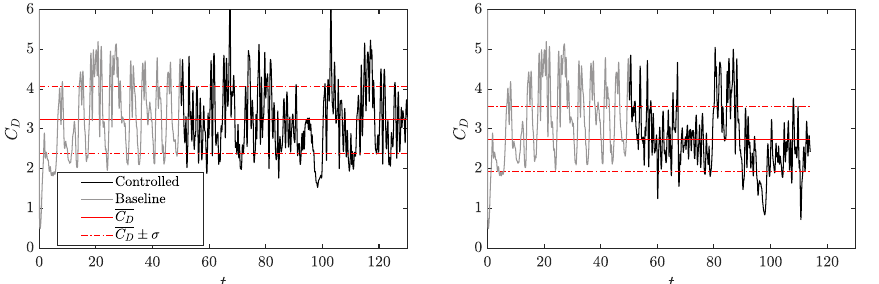
Figure 17. Temporal evolution of C D obtained through cross-application of agents trained at Re = 100 ( left ) and Re = 1000 ( right ) in a deterministic mode to a case with a Reynolds number of